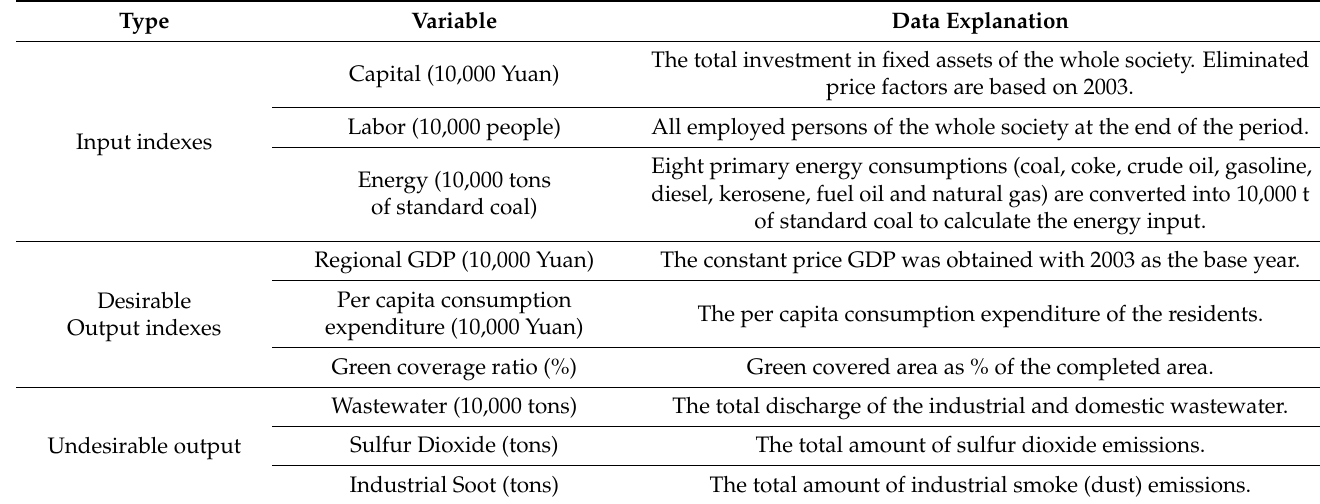
Table 1. Evaluation indicator system of the IGGE in